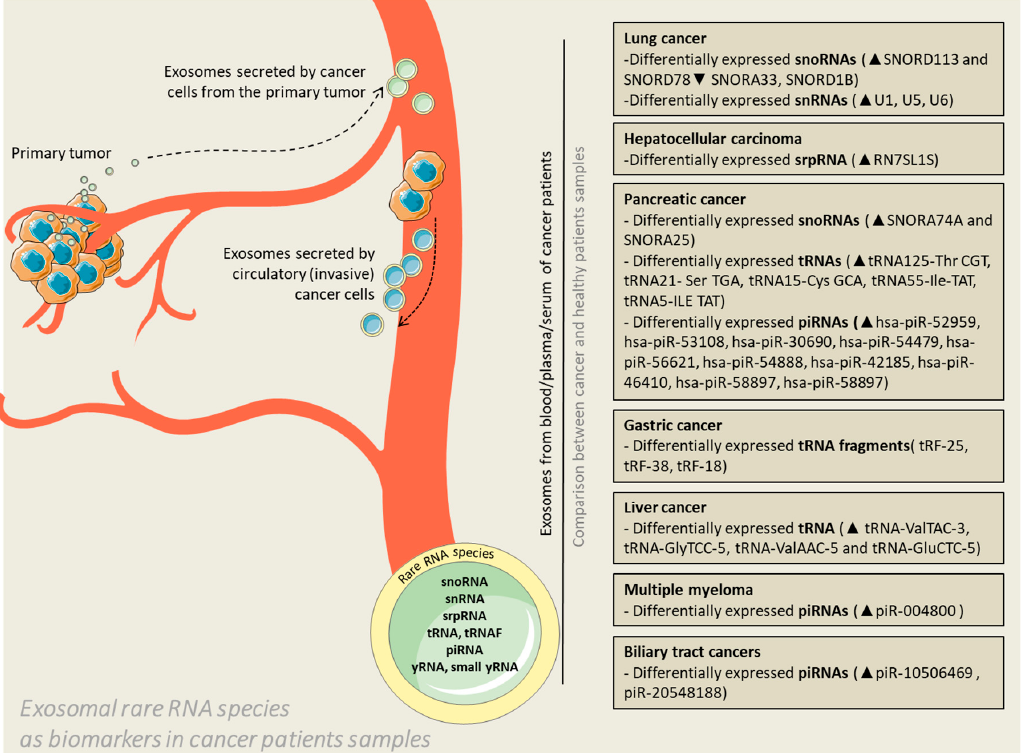
Figure 1. Exosomal rare RNA species as biomarkers in cancer patients’ samples. Exosomes are released by cancer cells in the extracellular environment with the purpose of facilitating communication with neighboring or distant cells. The vesicles can cross the blood barrier and enter the circulation; therefore, liquid biopsies conducted by means of blood, plasma or serum samples can become reliable diagnostic samples or even predictors of potential therapeutic targets. The context of exosomes (represented in the figure by rare RNAs) is the actual substrate for differentiation of patients in terms of health status.